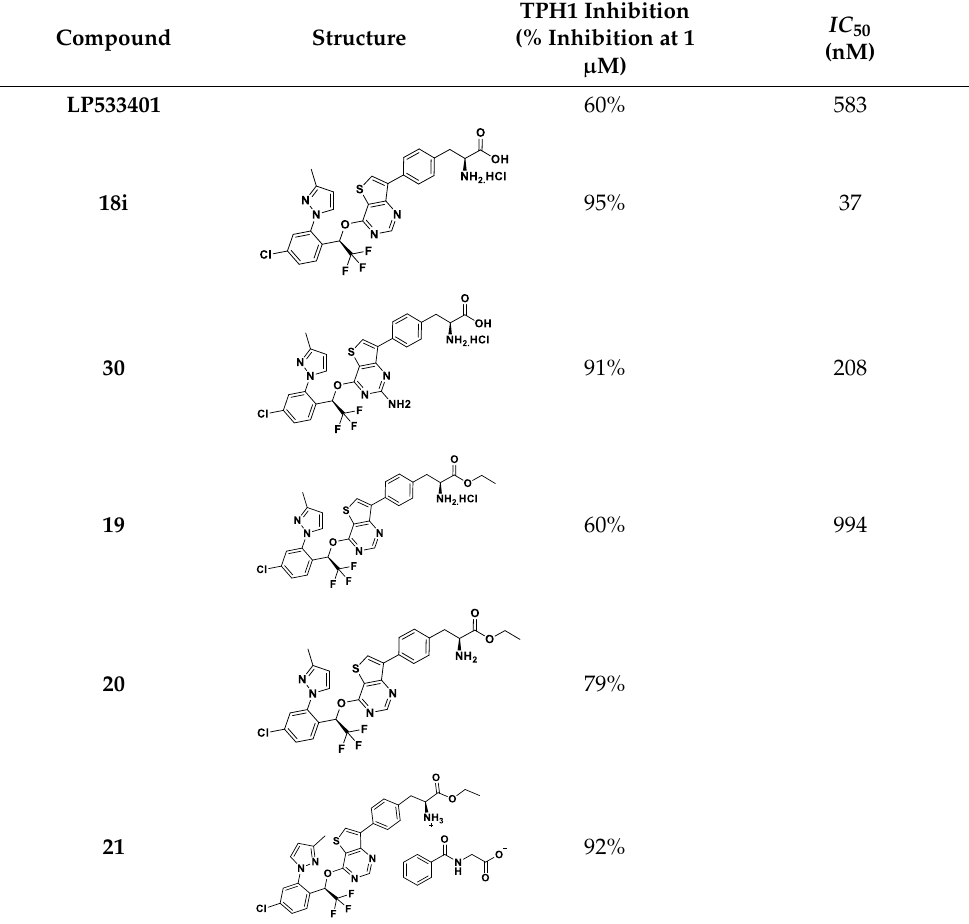
Table 3. In vitro test of amino thienopyrimidine derivative and prodrugs of compound 18i . Compound